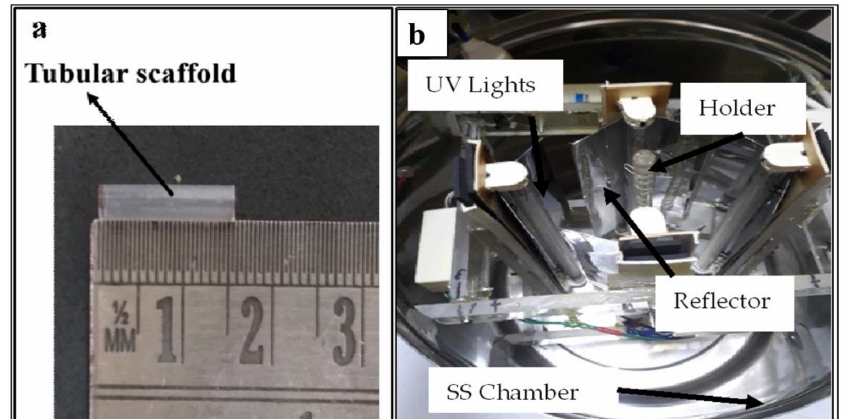
Figure 2. ( a ) The image showing fabricated tubular scaffold length and ( b ) an in-house manufactured UV treatment setup.